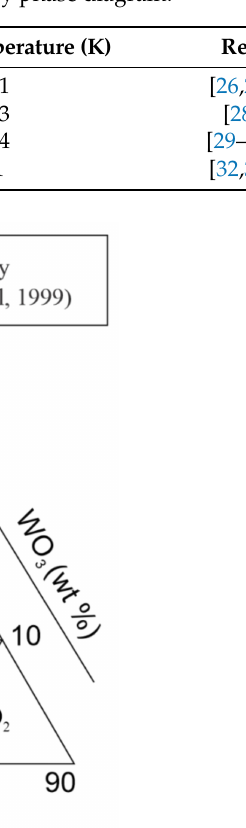
Table 4. Properties of the crystalline solids present in the ternary phase diagram.